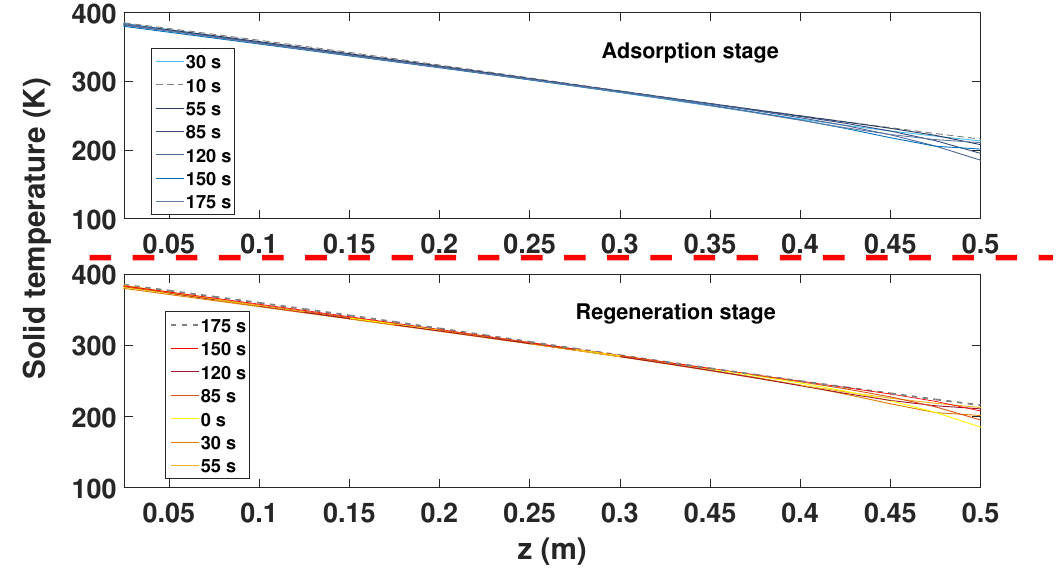
Figure 15. Molar fraction of ethanol–water during the adsorption phase while in the CSS. To determine the input values that may affect the performance of the model, modifications were made to the nominal model and the results of ethanol purity were obtained (Table